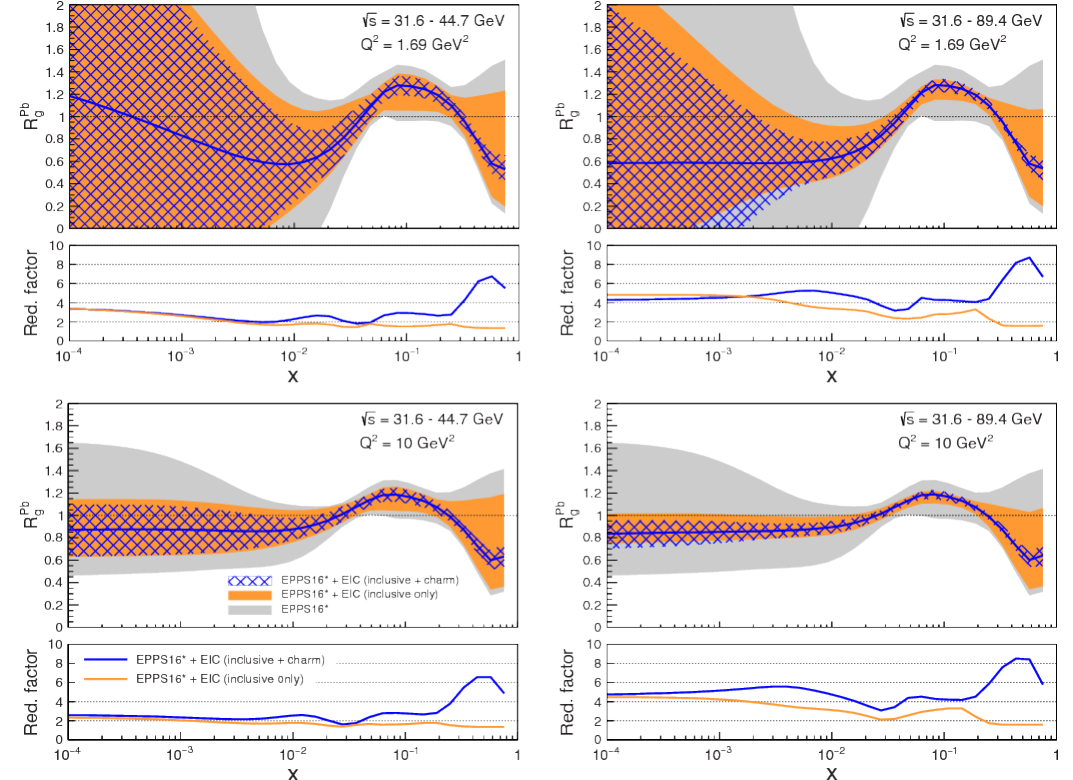
Figure 16. Left: The ratio R Pb g , from EPPS16 ∗ , of gluon distributions in a lead nucleus relative to the proton, for two different momentum transfers Q 2 possible at the EIC (higher on the bottom figures). Right figures correspond to a larger center of mass energy range considered. The grey band represents the current theoretical uncertainty. The orange (blue hatched) band includes the EIC simulated inclusive (charm quark) reduced cross-section data. The lower panel in each plot shows the reduction factor in the uncertainty with respect to the baseline fit; figures from